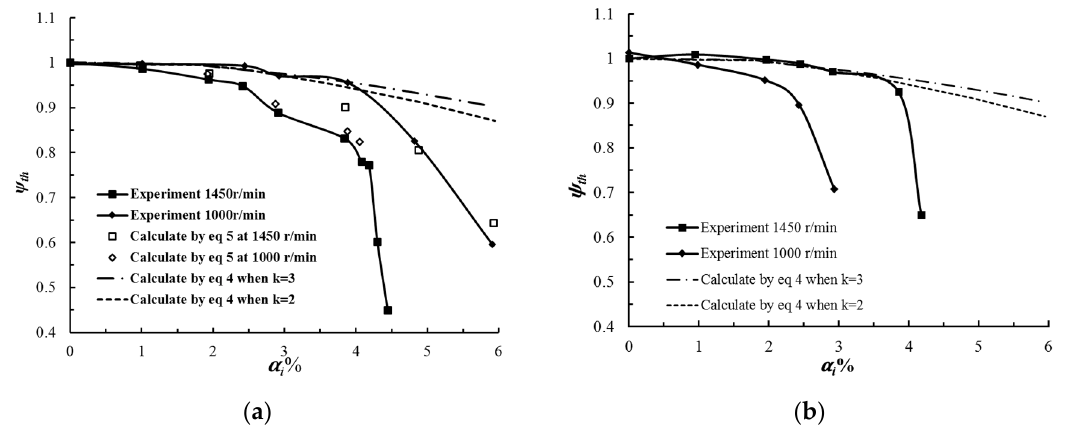
Figure 9. Changes in theoretical pump degradation for two different flow rates: ( a ) ϕ = 0.06; ( b ) ϕ = 0.04.